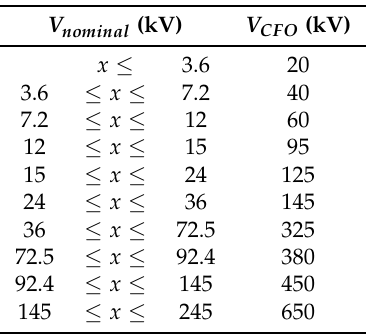
Table 1. Insulation voltage levels: V CFO